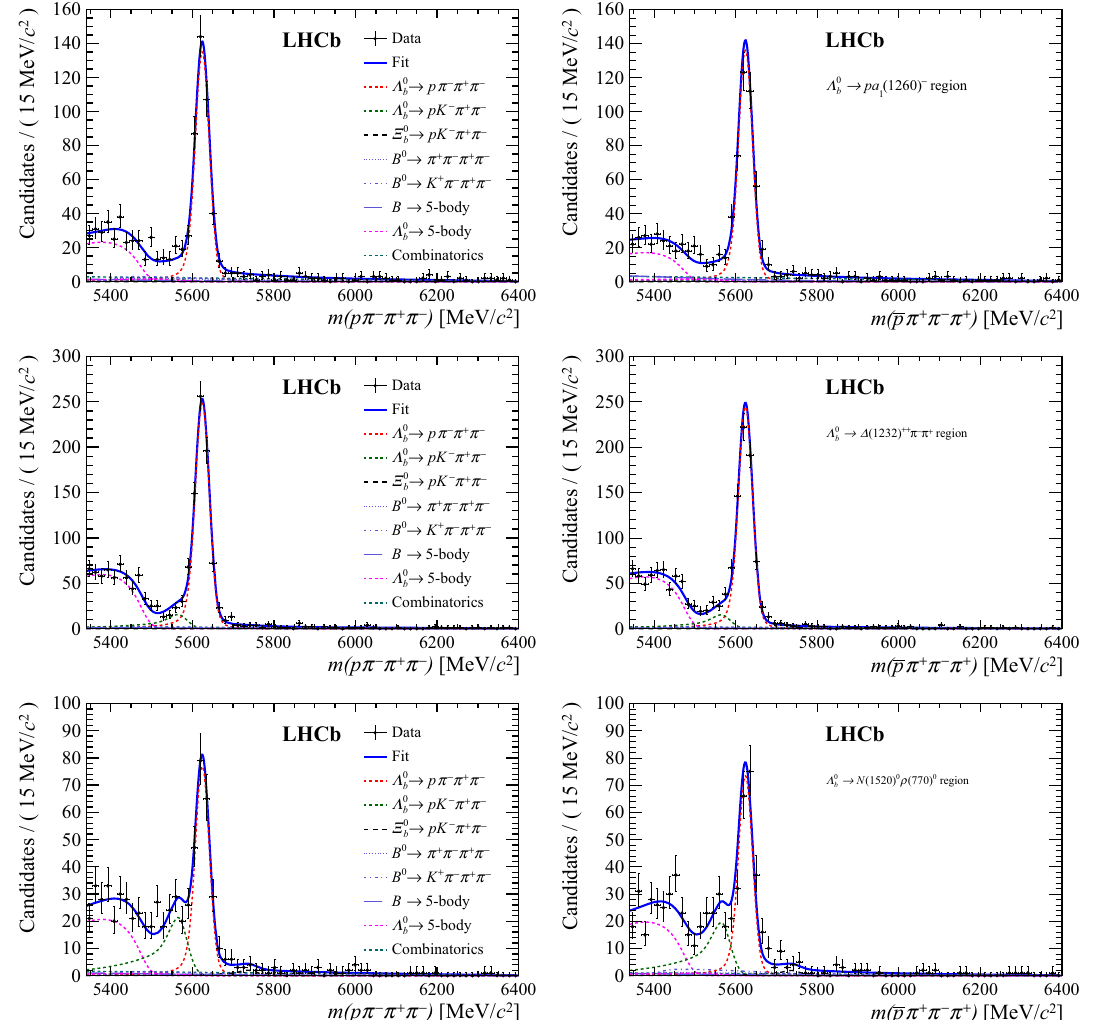
Fig. 3 Invariant p π − π + π − mass distributions with the results of the fit superimposed: region of the phase space containing (first row) Λ 0 → pa ( 1260 ) − , (second row) Λ 0 → Δ( 1232 ) ++ π − π − and 1 b b → N ( 1520 ) 0 ρ( 770 ) 0 quasi two-body decays. The (third row) Λ 0 b two columns correspond to the charge-conjugate final states: (left)